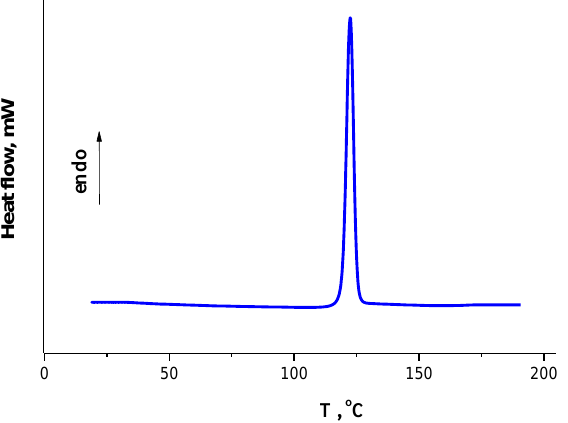
Figure 2. DSC curve of isavuconazole obtained by heating with rate 2 K · min − 1 .